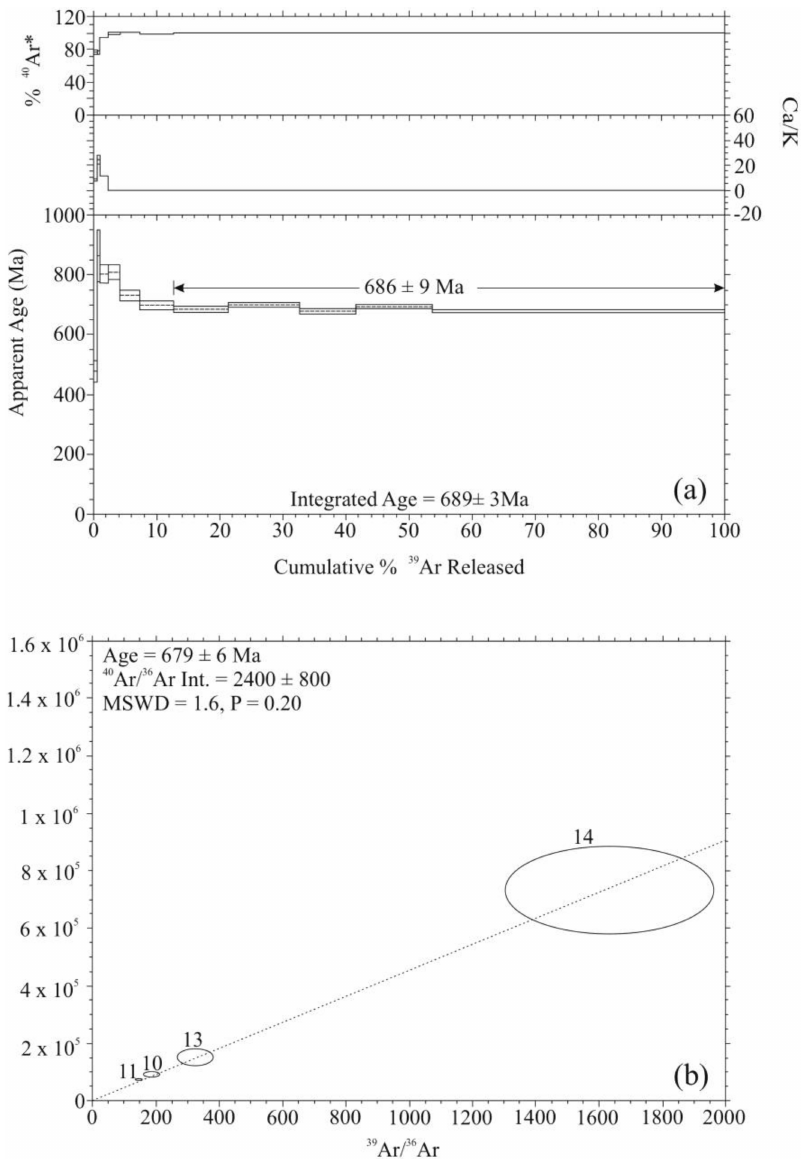
Figure 8. ( a ) Age spectrum for Vinoren phlogopite with an arithmetic average age of 686 ± 9 Ma of the last 5 steps, *radiogenic 40 Ar; ( b ) normal isochron for Vinoren phlogopite from the last five